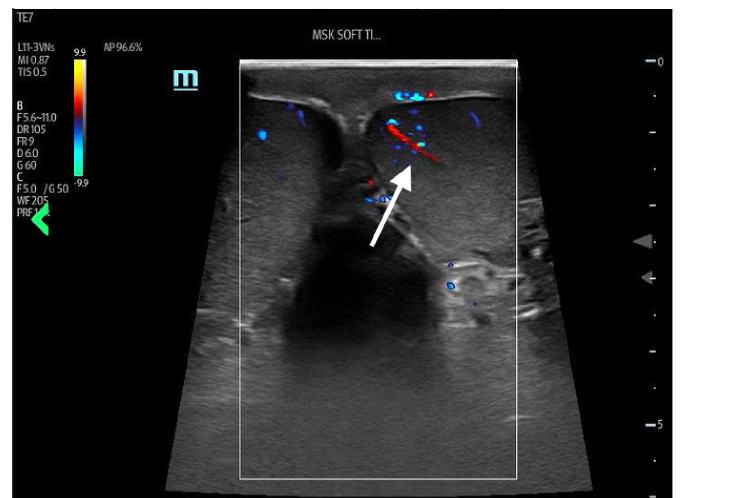
Image 2. Side-by-side view of testicular assessment with point- of-care ultrasound after manual detorsion. The testicle on the image-right corresponds to the patient’s left testicle, with bilateral appreciable Doppler flow highlighted by the included arrow.